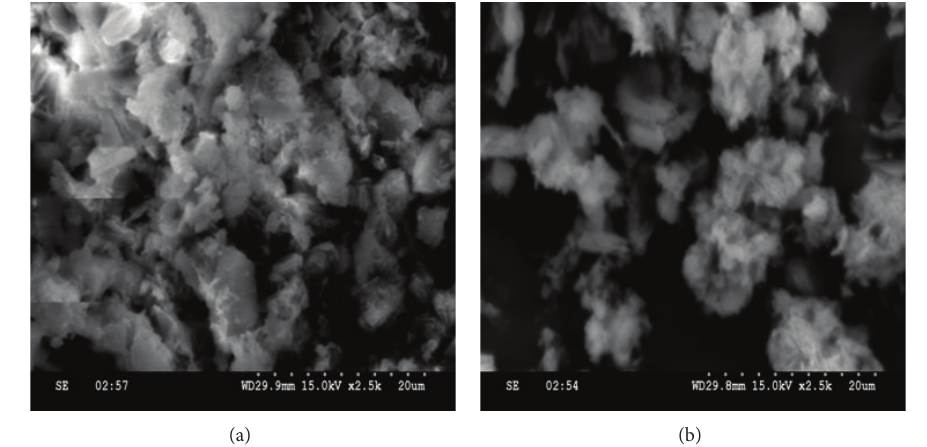
Figure 6: SEM micrograph of (a) [Ni(L 3 ) 2 ] ⋅ H 2 O and (b) [Ni(L 4 ) 2